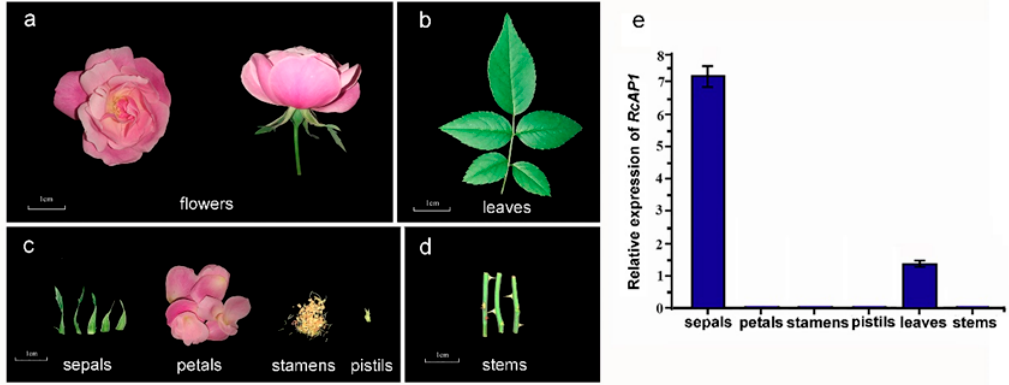
Figure 3. Expression of RcAP1 in different ‘Old Blush’ organs. ( a ) Front and side views of fully-bloomed flowers. ( b ) Compound leaves. ( c ) Floral organs, including sepals, petals, stamens, and pistils. ( d ) Stems. Scale bar, 1 cm. ( e ) Quantitative analysis of RcAP1 expression in different ‘Old Blush’ organs. Error bars represent the standard deviation.